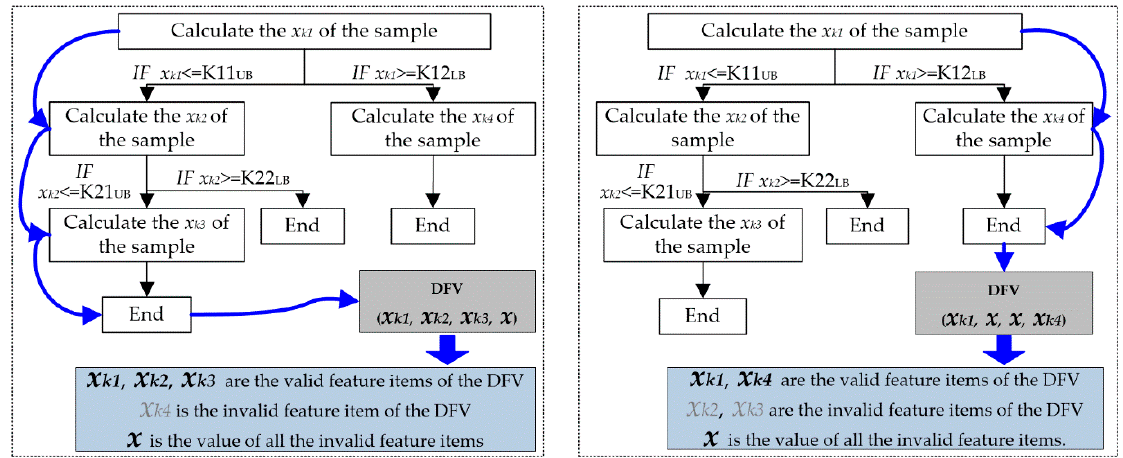
Figure 6. DFV extraction.